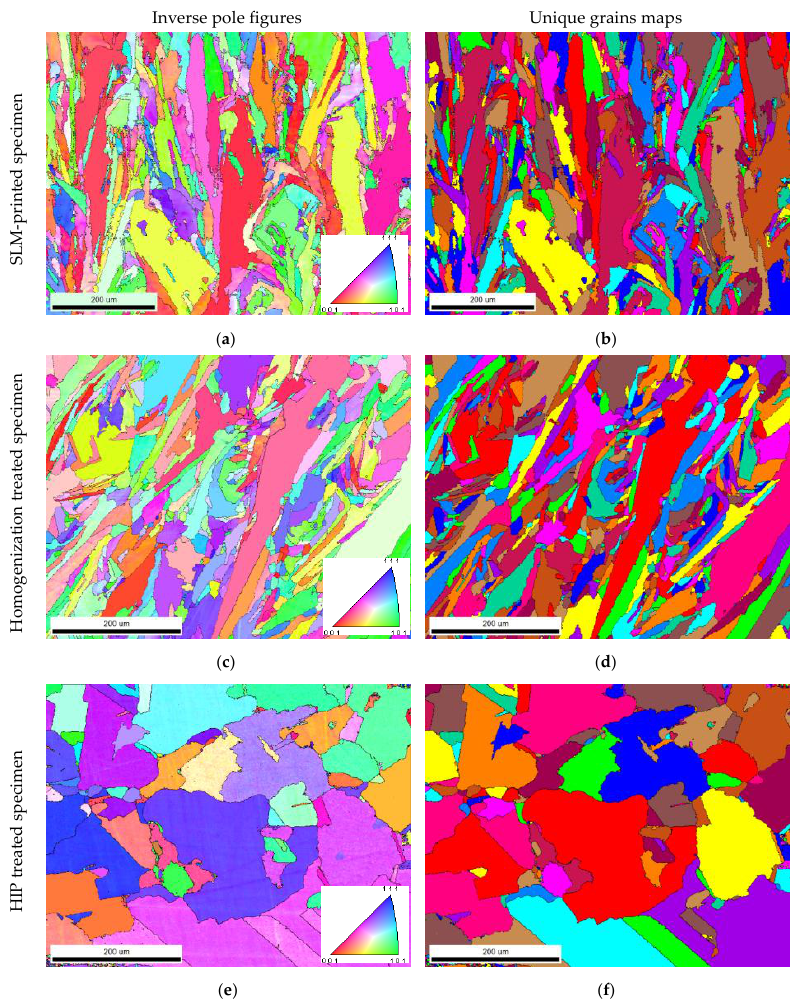
Figure 18. Inverse pole figures and unique grain maps of ( a , b ) SLM-printed; ( c , d ) homogenized; ( e , f ) HIP-treated IN718